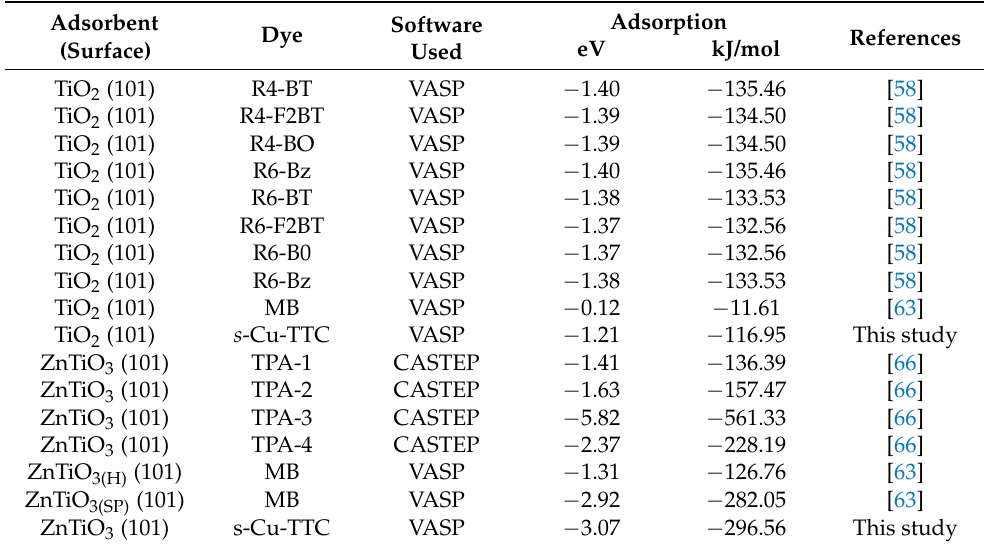
Table 4. Calculated adsorption energy values of s-Cu-TTC on ZnTiO 3 and TiO 2 and other values of several dyes reported in the